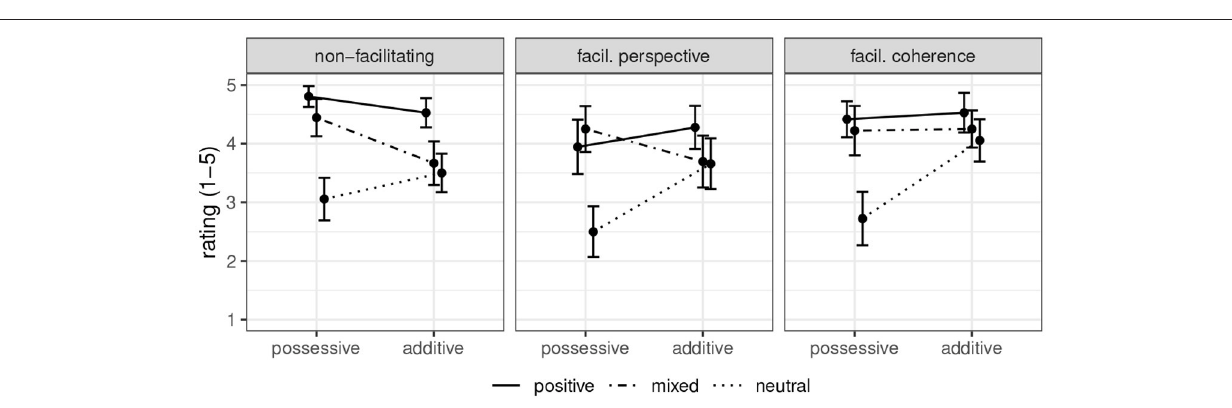
FIGURE 4 | Felicity rating results of experiment 1 with 95% confidence intervals, split by discourse type.